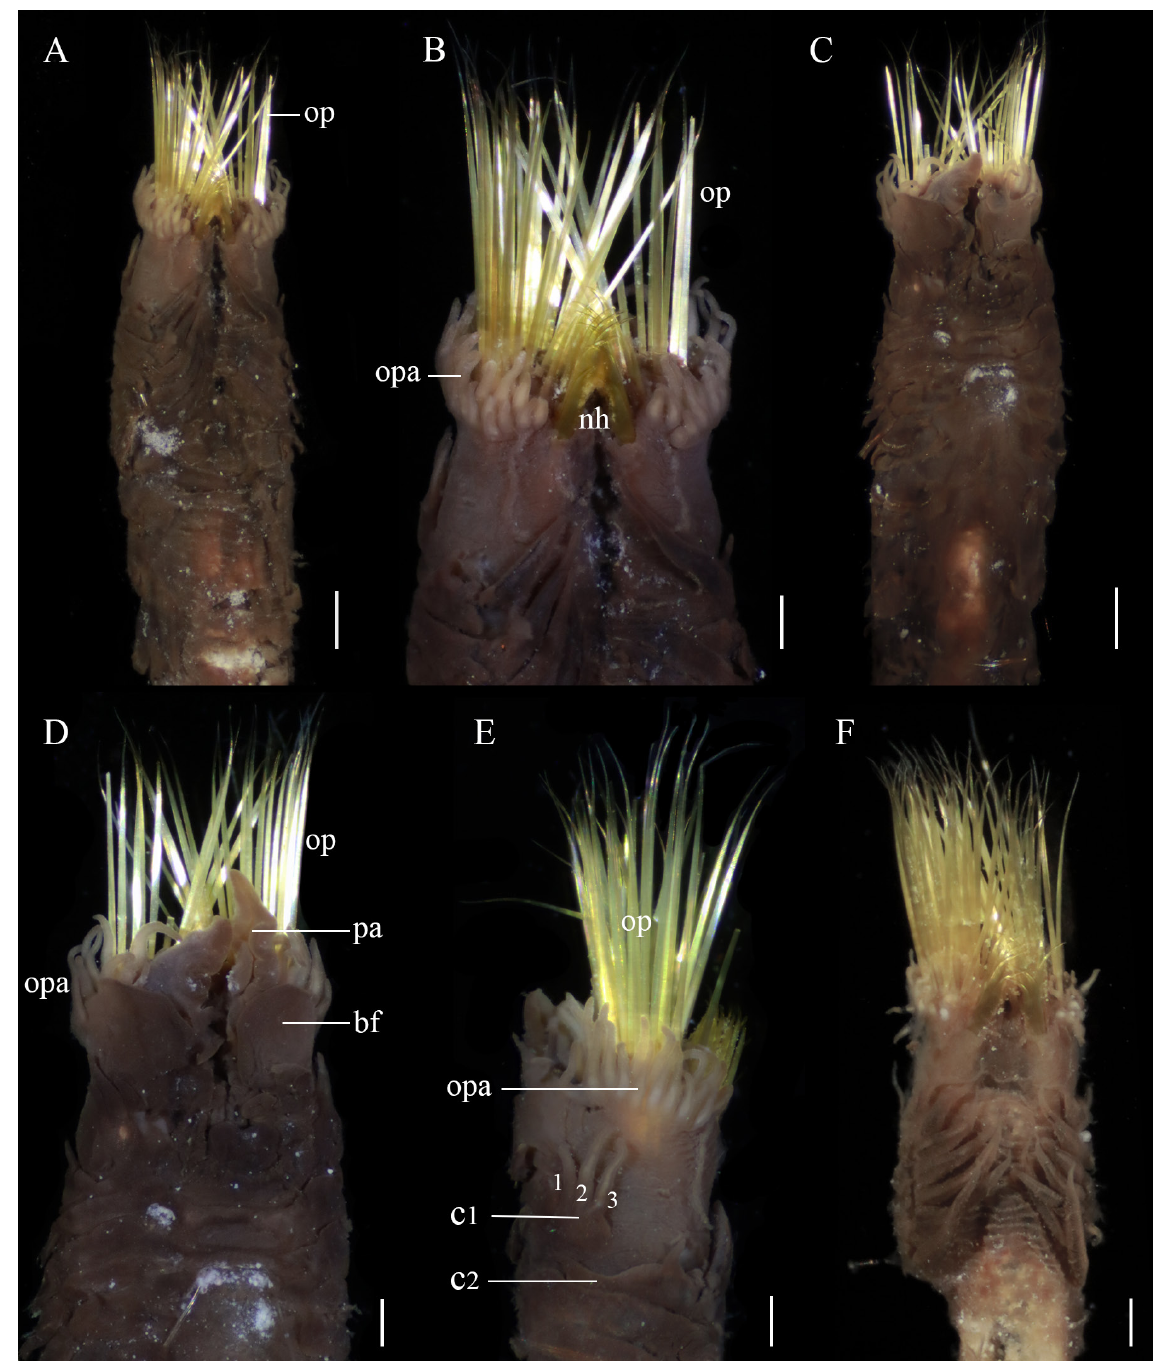
Fig. 13. Phalacrostemma perkinsi Kirtley, 1994 (UMML-22.1191). A . Anterior region, dorsal view. B . Operculum, dorsal view. C . Anterior region, ventral view. D . Operculum, ventral view. E . Anterior region, lateral view. F . Another specimen (UMML-22.1192). Abbreviations: bf = buccal flaps; c1 = cirri 1 st thoracic segment; c2 = cirri 2 nd thoracic segment; nh = nuchal hooks; op = outer paleae; opa = opercular papillae; pa = palps. Numbers indicate the cirri. Scale bars: A, C = 1 mm; B, D–F = 0.5